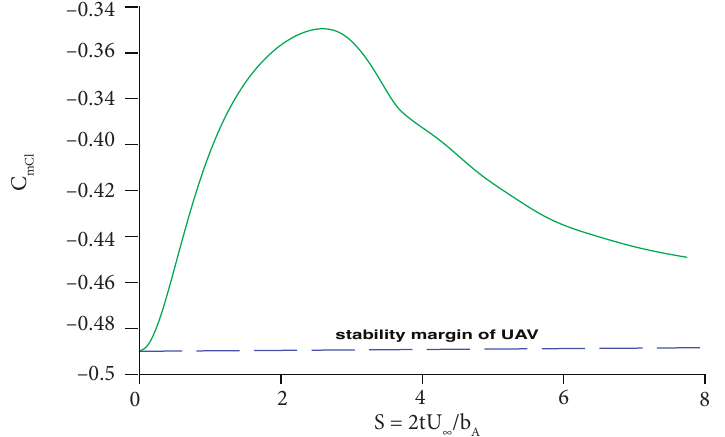
Figure 11. Change curve of static stability margin of the UAV under 1-cos